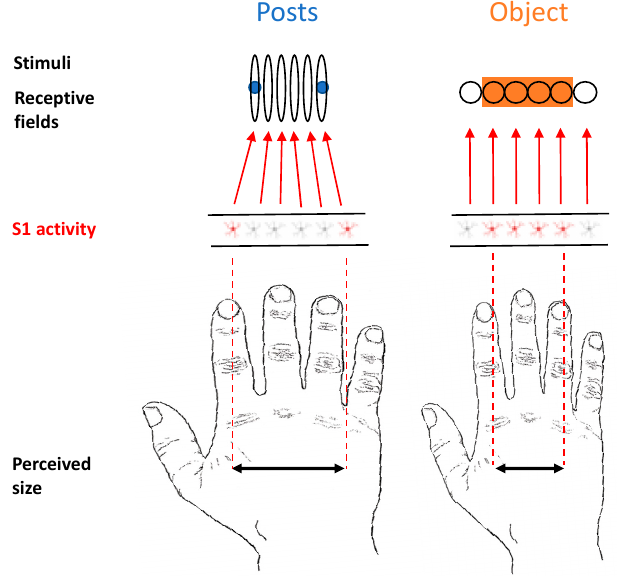
Figure 7. Depiction of the model that we propose of perceived size representation in the primary somatosensory cortex when objects are in contact with the skin surface.